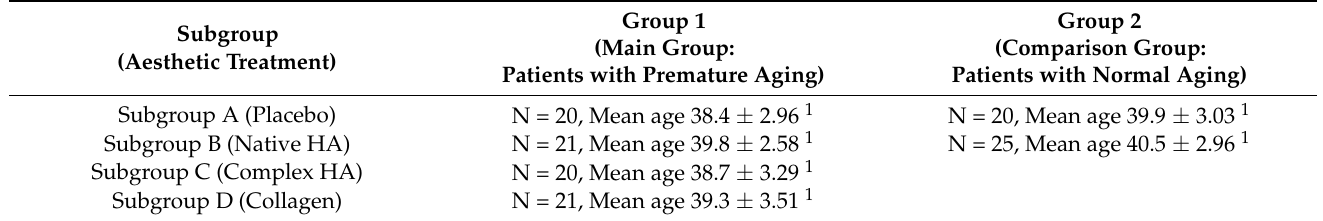
Table 1. Distribution of patients into groups and subgroups, depending on the aesthetic treatment. Subgroup